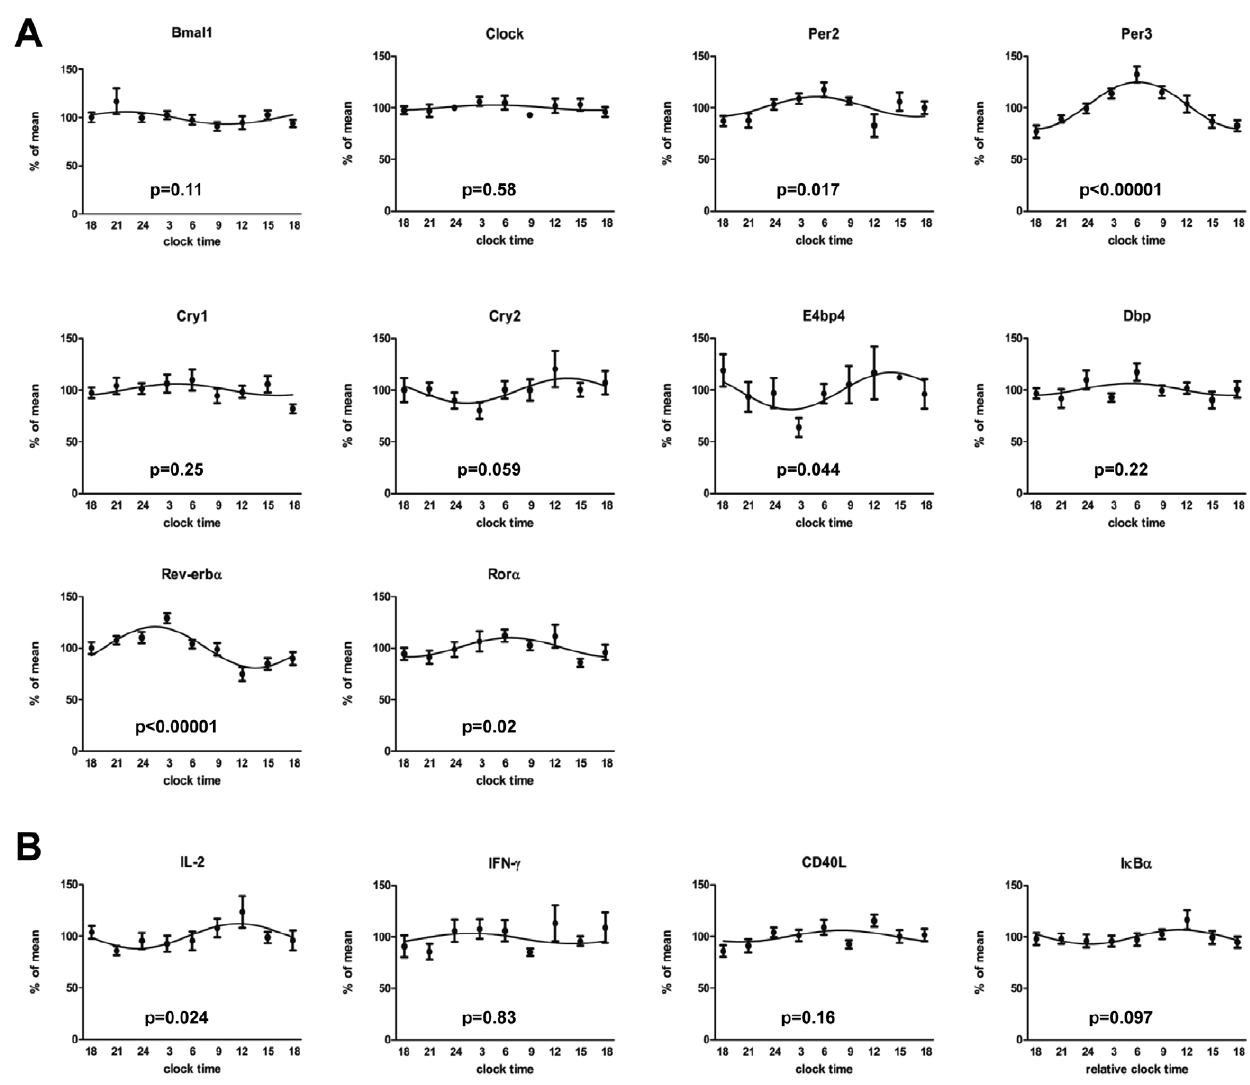
Figure 3. Circadian clock gene expression in purified CD4 + T cells ex vivo. Blood was sampled from seven healthy young males in three hours intervals starting at 6 PM over a 24 h period. CD4 + T cells were isolated from whole blood by MACS technology and the purified CD4 + T cells (mean purity: 94.99% 6 0.5%) were lysed, RNA was isolated, and the mRNA of ten clock genes was analyzed by qPCR. Depicted are the mRNA levels of clock genes (A) and immune genes (B) relative to the reference genes B2M , HPRT , PBGD , and G6PDH . The p-values depicted in each graph were calculated by Cosinor analysis (Table. S2). Table. S2). In addition, we found rhythmic expression of nuclear factor of kappa light polypeptide gene enhancer in B-cells